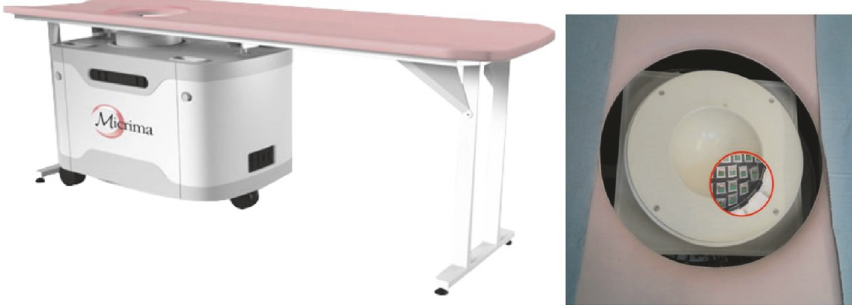
Figure 23: Breast imaging system “MARIA (cid:2) ” of MICRIMA [27]. Image copyright Micrima Ltd.